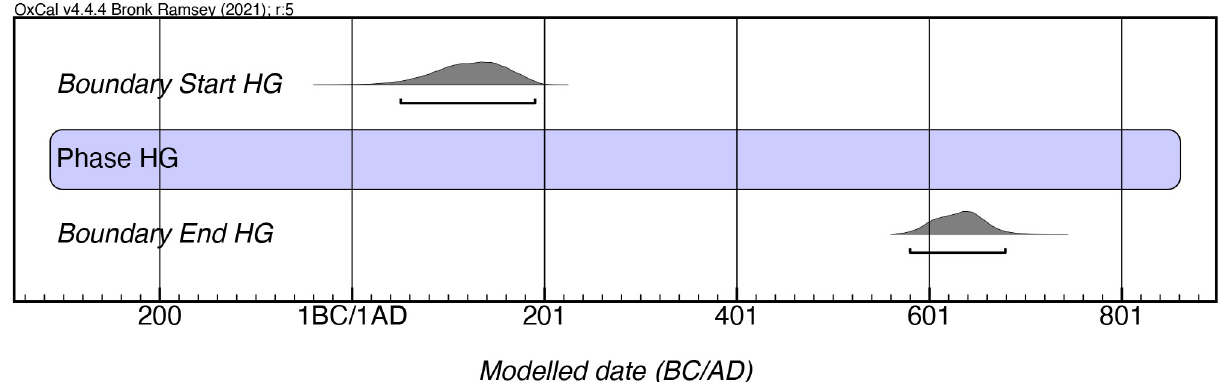
Fig 6. Modeled date ranges for the Hacienda Grande style. Probability distributions indicate modeled 2 σ (95.4%) confidence intervals for beginning and end of phase.